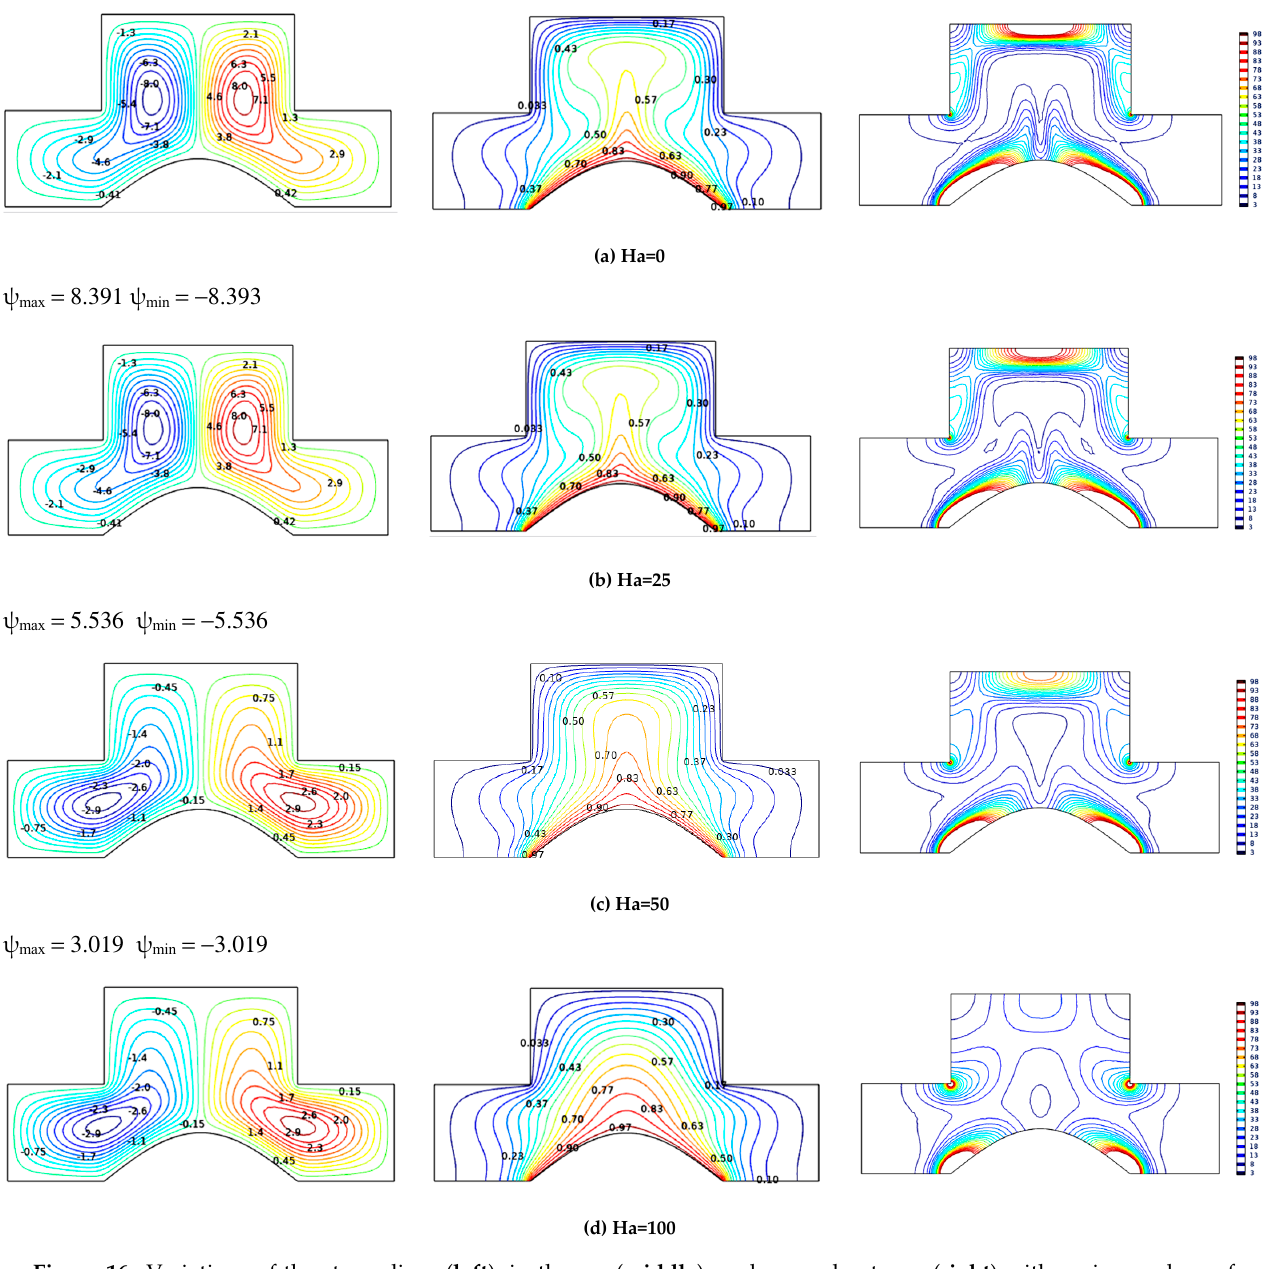
Figure 16. Variations of the streamlines ( left ), isotherms ( middle ), and general entropy ( right ) with various values of Hartmann number (Ha). 𝜙 = 0.02, Ra=10 6 , Da = 0.01, and 𝜀 = 0.4 .